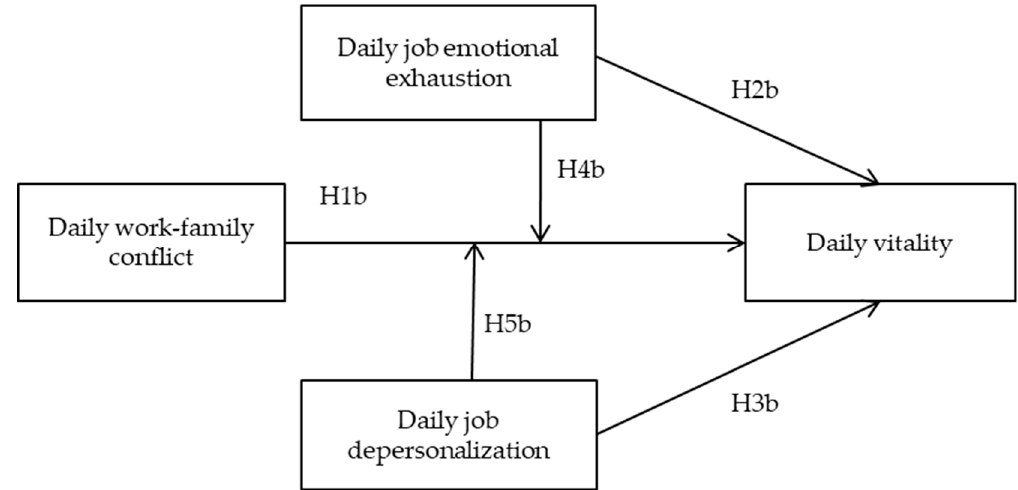
Figure 2. Research model and hypotheses to explain daily vitality levels.